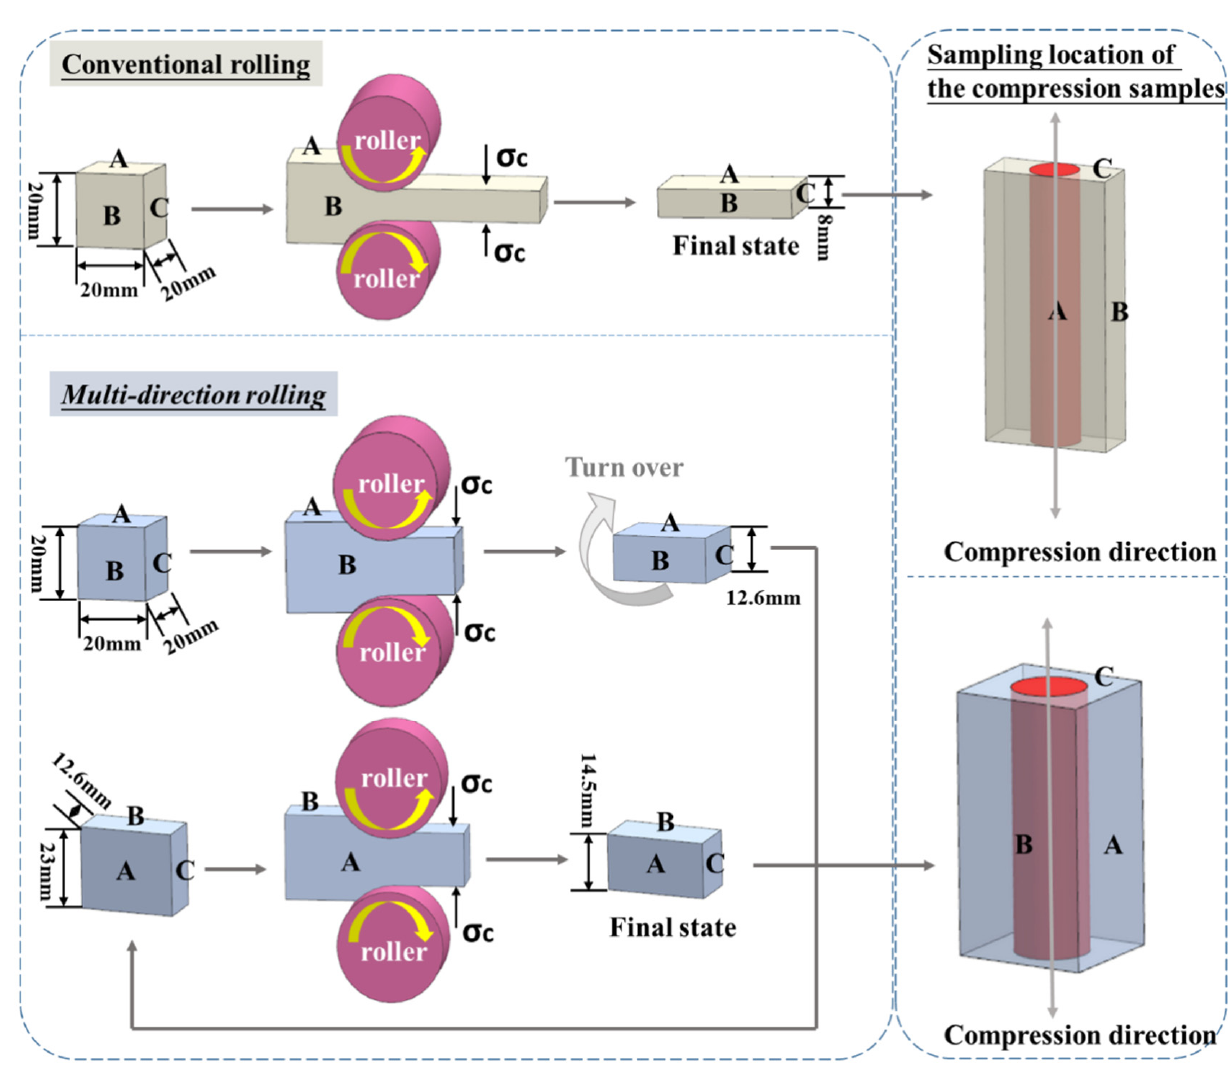
Figure 1. Schematic diagram of rolling and the locations of compression samples in as-rolled samples [18].